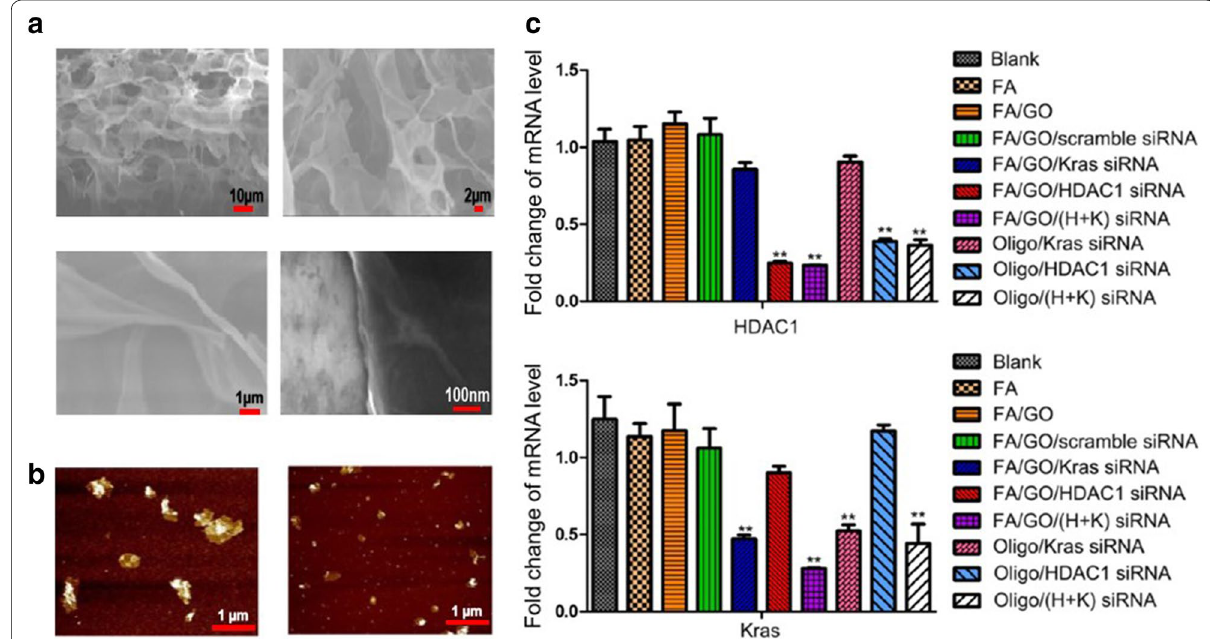
Fig. 6 a SEM and b AFM images of GOx. c Regulated mRNA level of targeted HDAC1 and Kras genes (Reproduced with permission [52])